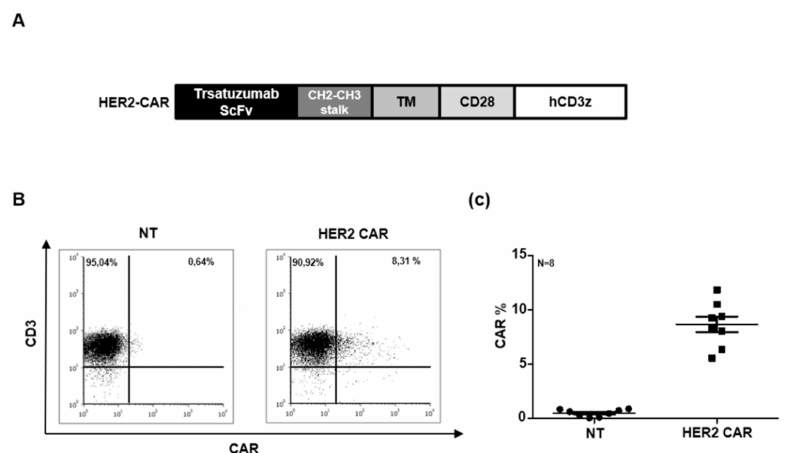
Figure 2. Generation of HER2 specific mouse CAR T cells: ( A ) Schematic diagram illustrating the modular composition of the retroviral vector encoding HER2 specific CAR. ( B , C ) Representative flow cytometry dot-plots and summary data (HER2 CAR mouse T cells ( n = 8) and non-transduced (NT) mouse T cells ( n =